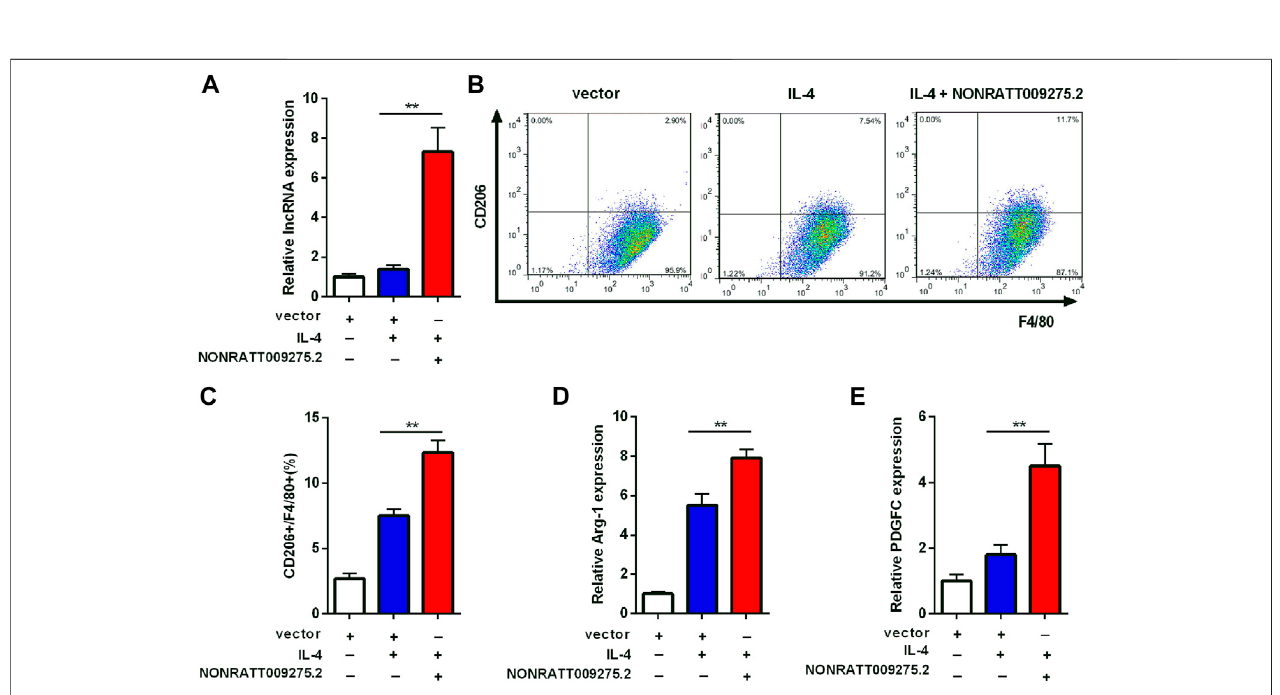
FIGURE 5 | LncRNA NONRATT009275.2 facilitated macrophage polarization to M2 type. (A) The expression level ofNONRATT009275.2 in transfected BMDMs. (B) The macrophage polarization was detected by fl ow cytometry. (C) The F4/80 and CD206 positive cells were quanti fi ed. (D,E) The Arg-1 and PDGFC mRNA expression were tested by qRT-PCR. GAPDHwasused asthe internal control. The data areexpressed as the mean ± SD ( n (cid:1) 3). ** p < 0.01 vs. theIL-4 + vector group.